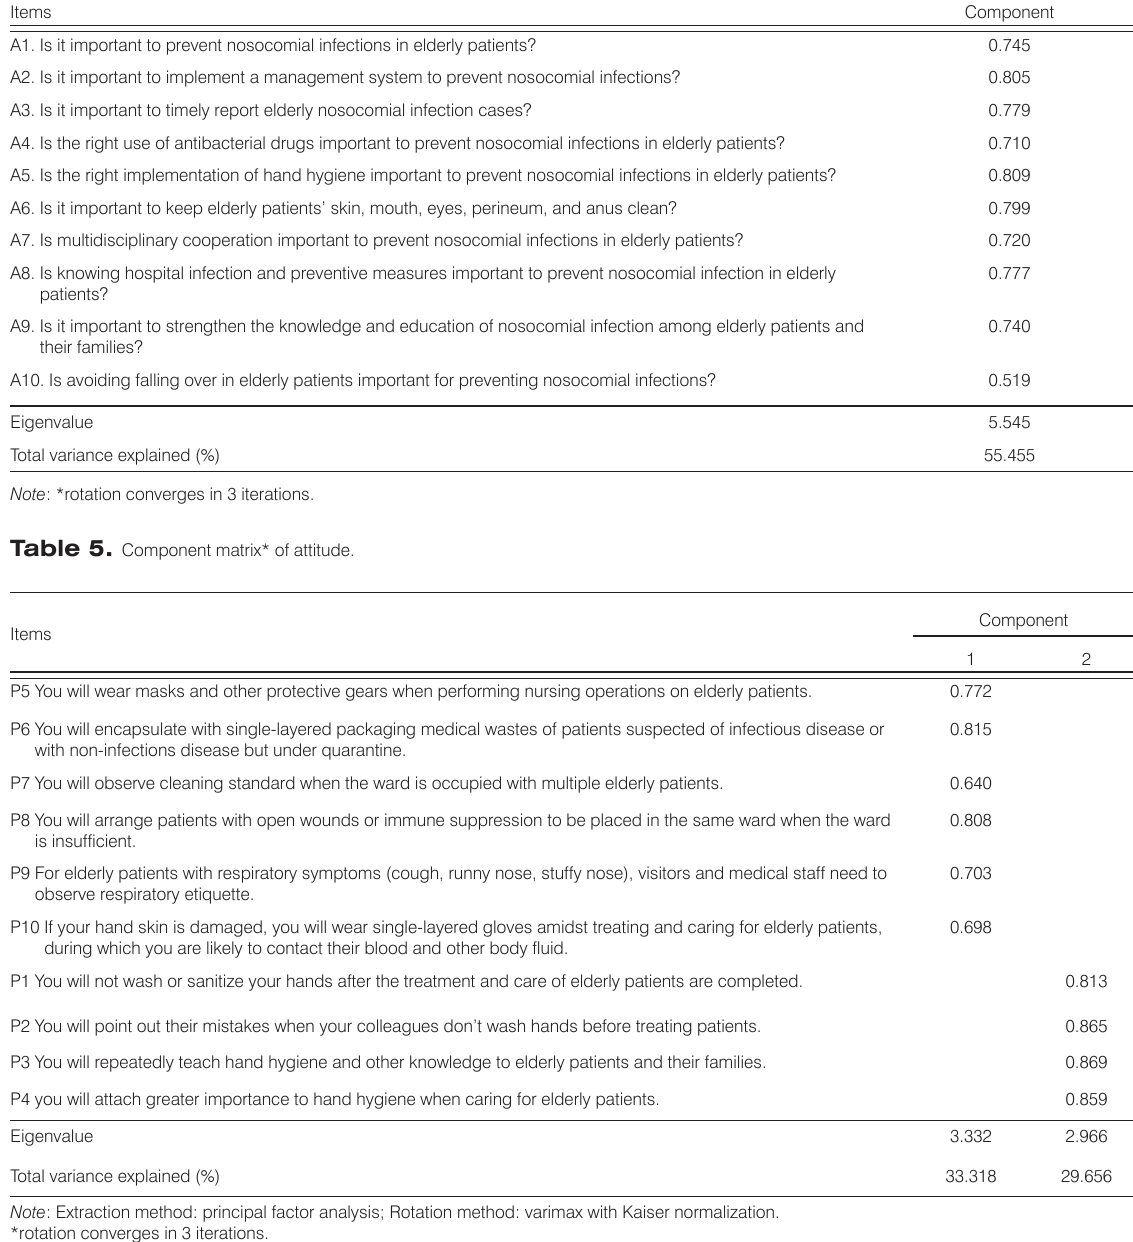
Table 6. Component matrix* of